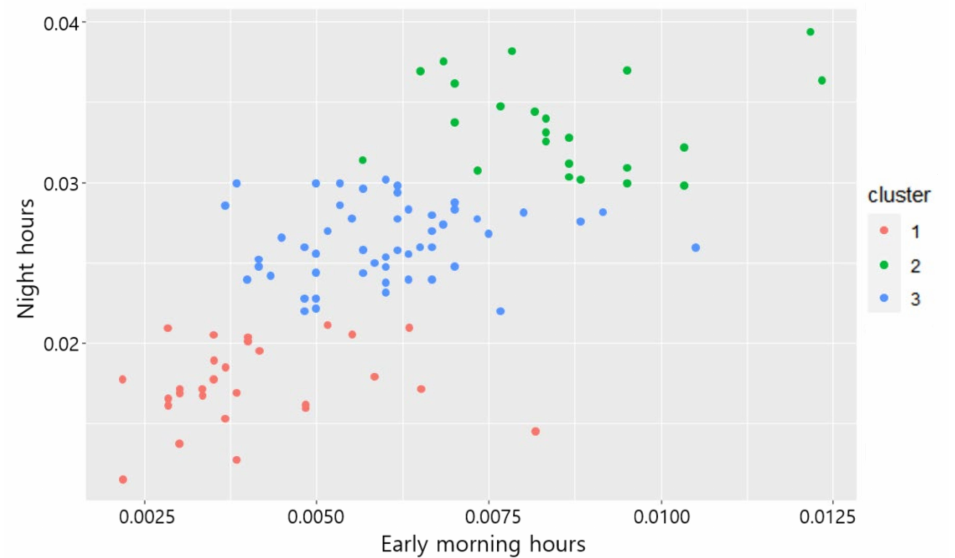
Figure 8. Scatter plot of the result of the clustering analysis for scenario